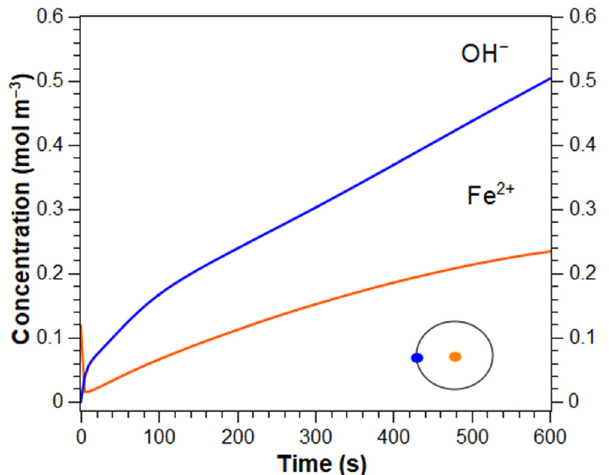
Figure 8. Variation of the ferrous ion concentration with time at a point in the center of the drop’s base (orange line); and the variation of OH − ion concentration with time located in the drop’s periphery represented by the upper, blue line.